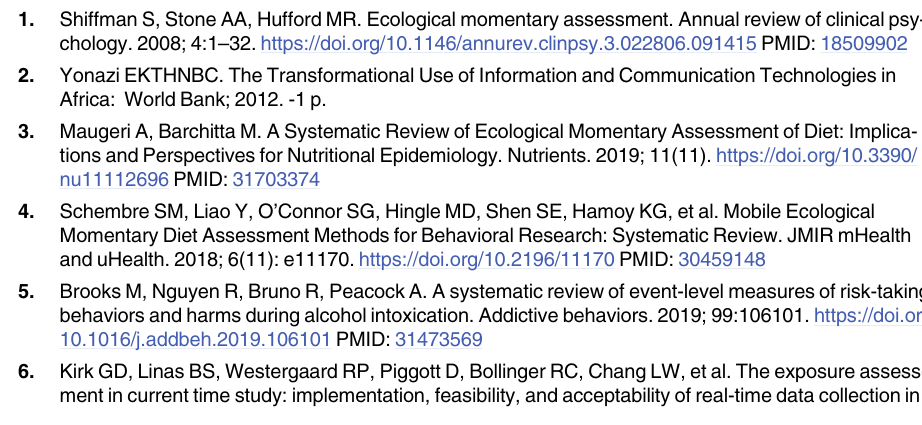
S2 Table. Sex and age distribution of risk behaviors reported